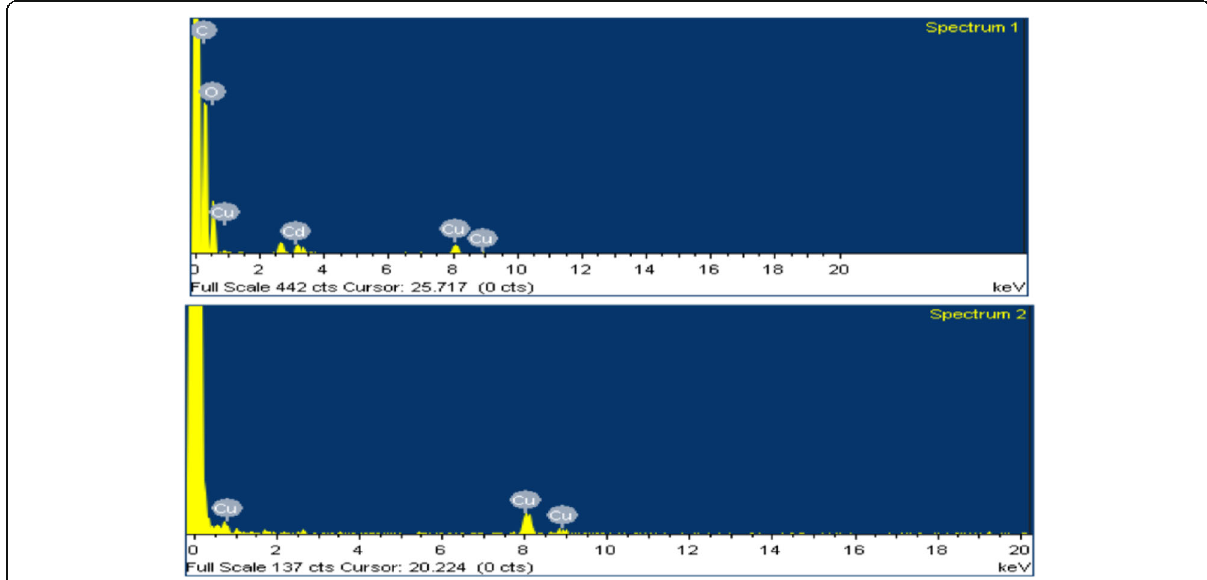
Fig. 5 EDAX images of a Cd(II) ion-loaded MWCNT-IIP and b Cd(II)-eluted MWCNT-IIP Cd(II) ion eluted